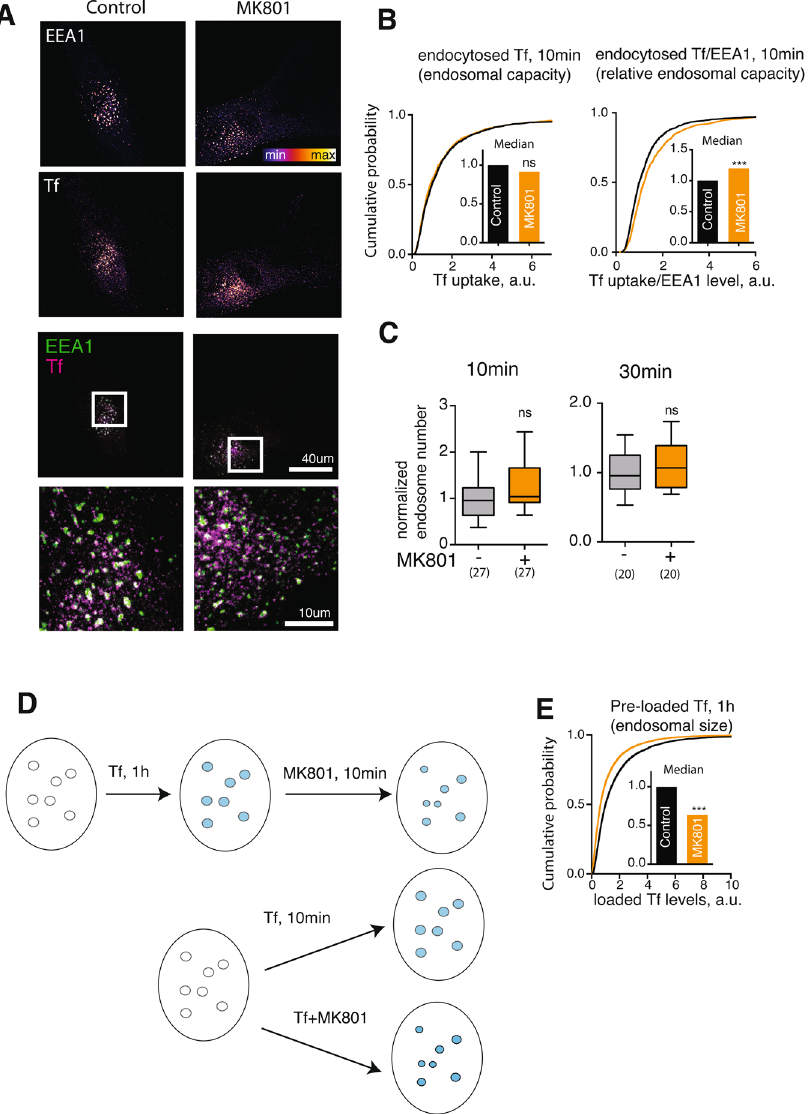
Figure 2. Regulation of trafficking through early endosomes by NMDAR signalling. ( A ) Representative image of fibroblasts incubated with fluorescent Tf in presence of MK801 for 10 min. Note the colocalisation of the internalised Tf signal with EEA1-positive puncta. ( B ) Quantification of the Tf level in EEs following MK801 treatment. Left, quantification of absolute Tf levels. Right, quantification of the Tf levels divided by the EEA1 levels. ns – not significant, *** P < 0.0001, Mann-Whitney U test. N = 50–250 EEs/image, 15 images /condition, 3 independent experiments. ( C ) Normalised endosome number per cell following MK801 treatment for 10 and 30 min. ns = not significant, Student’s t test. N = 15 cells/condition, 3 independent experiments. ( D ) Schematic